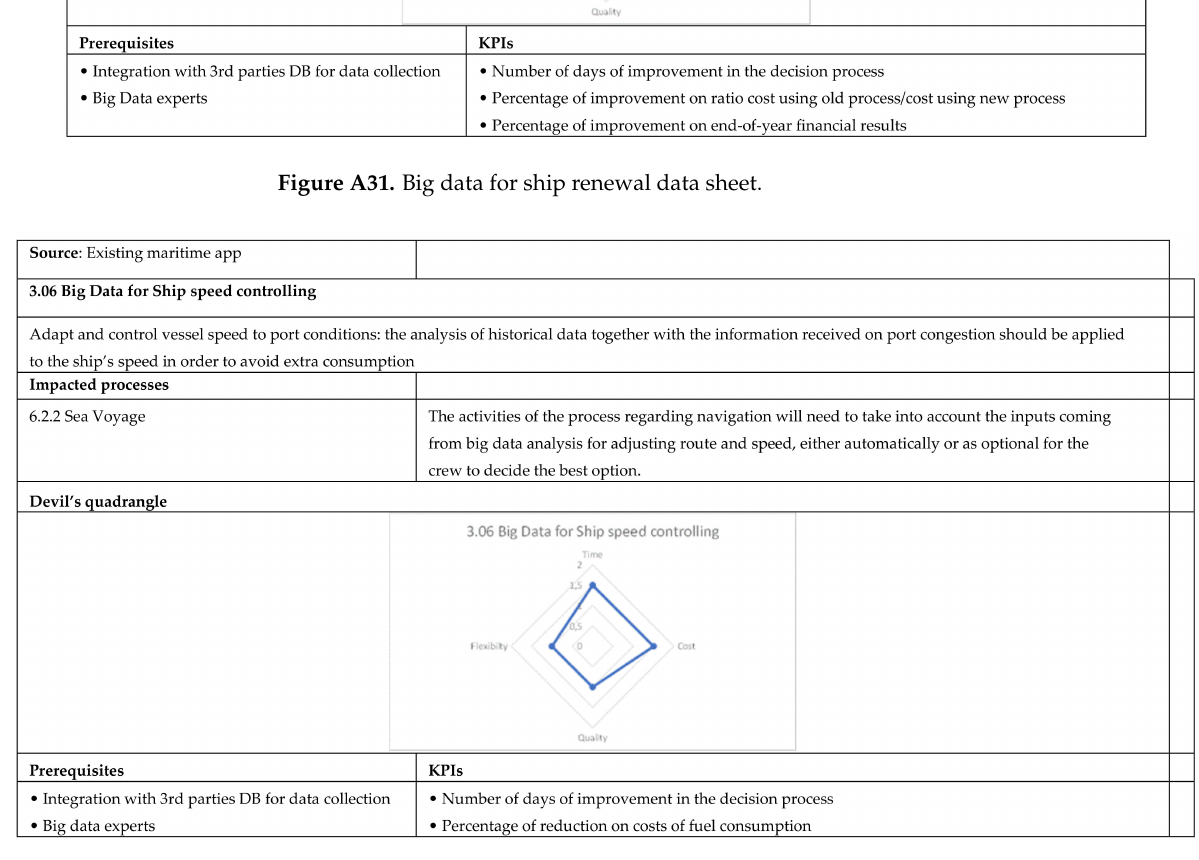
Figure A32. Big data for ship speed controlling data sheet.